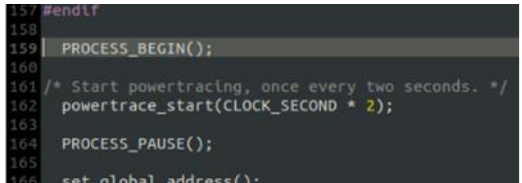
Figure 5 . Powertracing Begin . Figure 4 . “powertrace.h” library in the mote code .